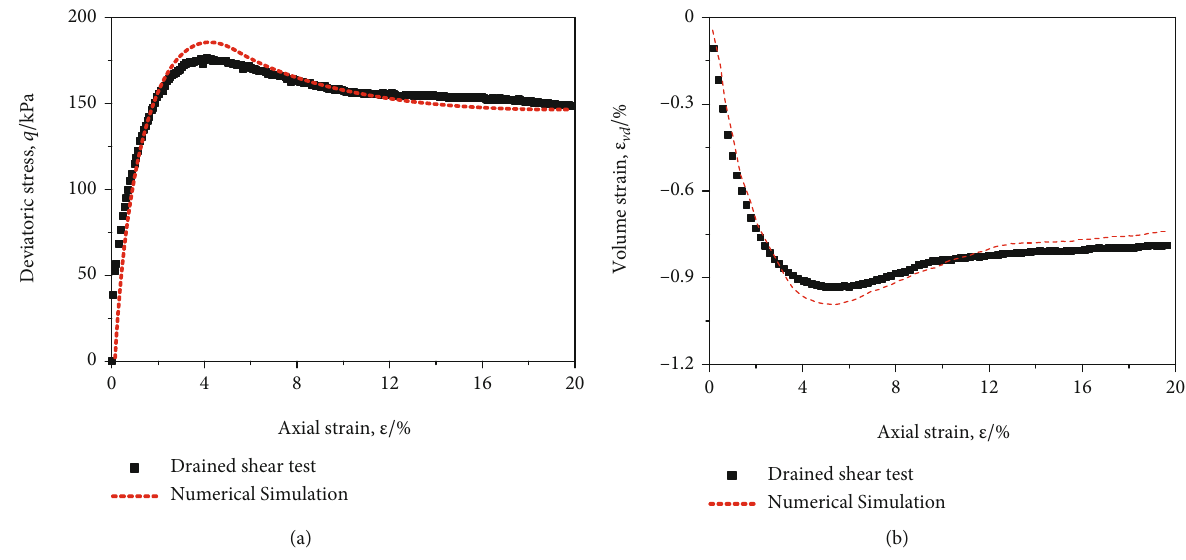
Figure 9: Deviatoric stress-axial strain and volume strain-axial strain curves of drained shear test.